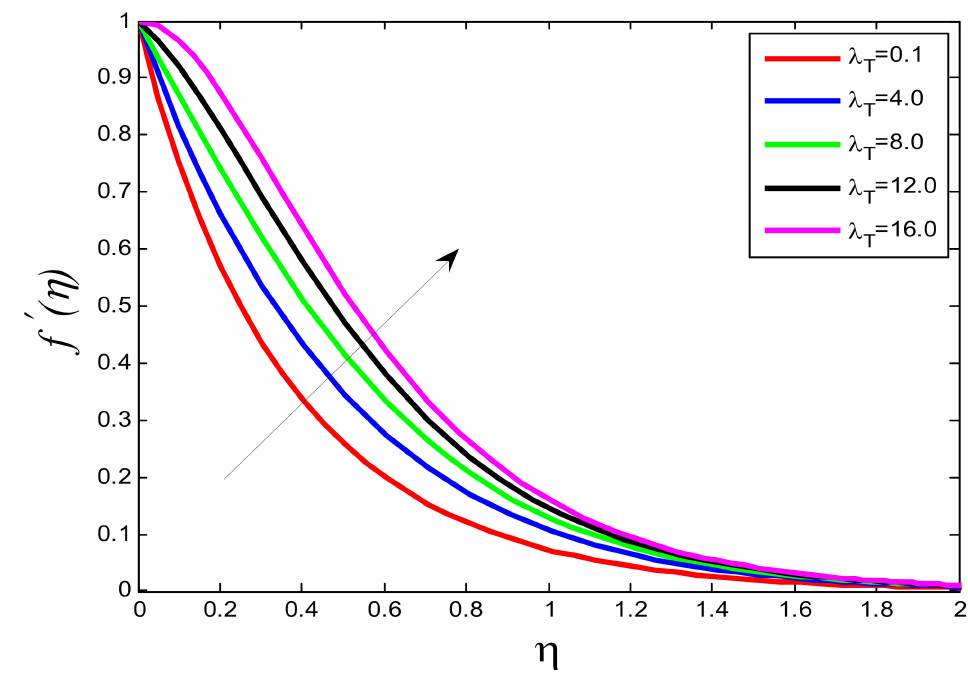
Figure 2. Influence of λ T on f (cid:48) ( η ) .